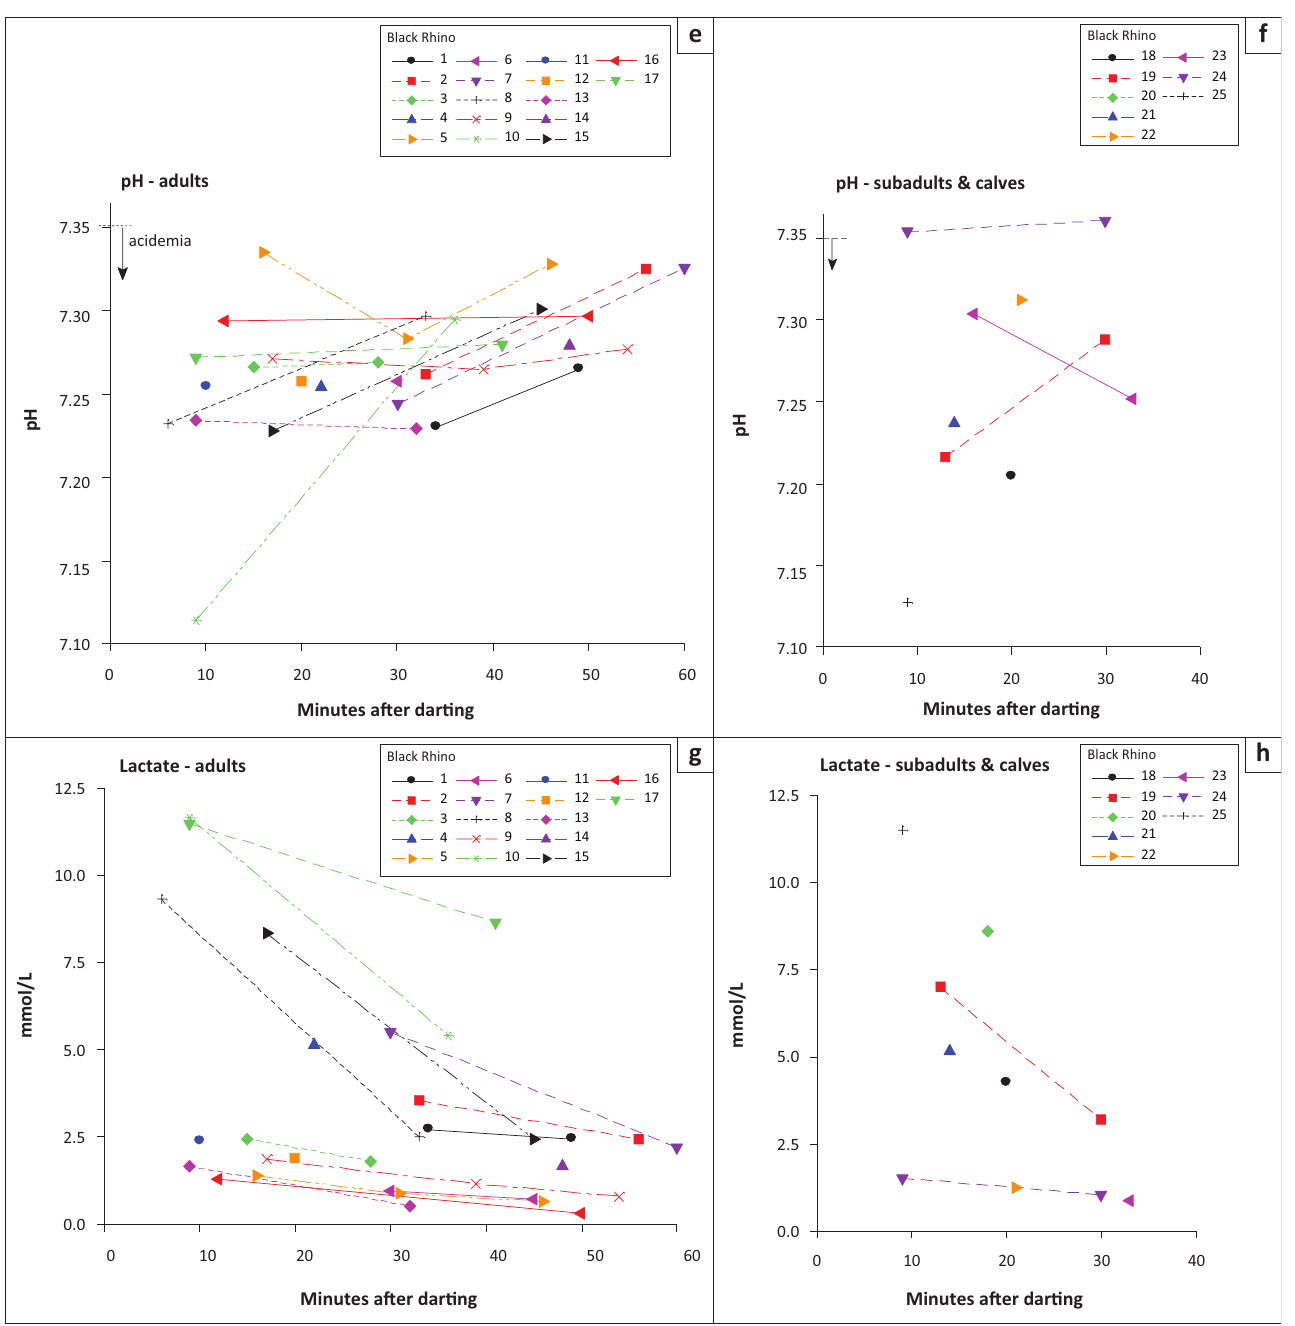
The rectal temperature ranged from 37.7 °C to 40.1 °C at the times of arterial sampling. Rectal temperatures > 39.0 °C were recorded in 11 free-ranging rhinoceroses, and the lowest temperature (35.5 °C) was recorded in the boma-held rhinoceros after ~1 h of immobilisation. Adverse effects recorded during immobilisation included muscle tremors and leg rigidity. Leg paddling occurred during lateral recumbency. Occasional ear twitching was recorded